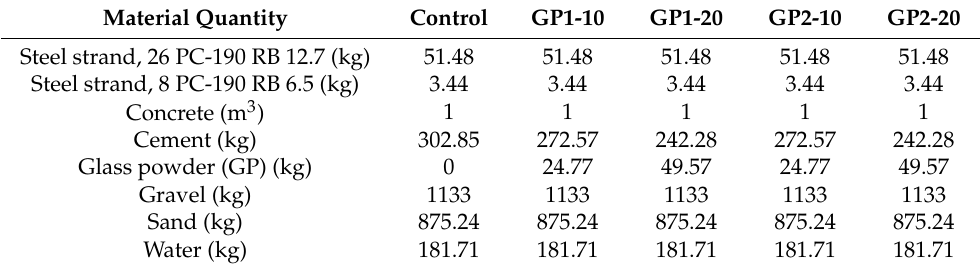
Table 1. Material quantity required to manufacture 1 m 3 of a prestressed hollow-core slab.